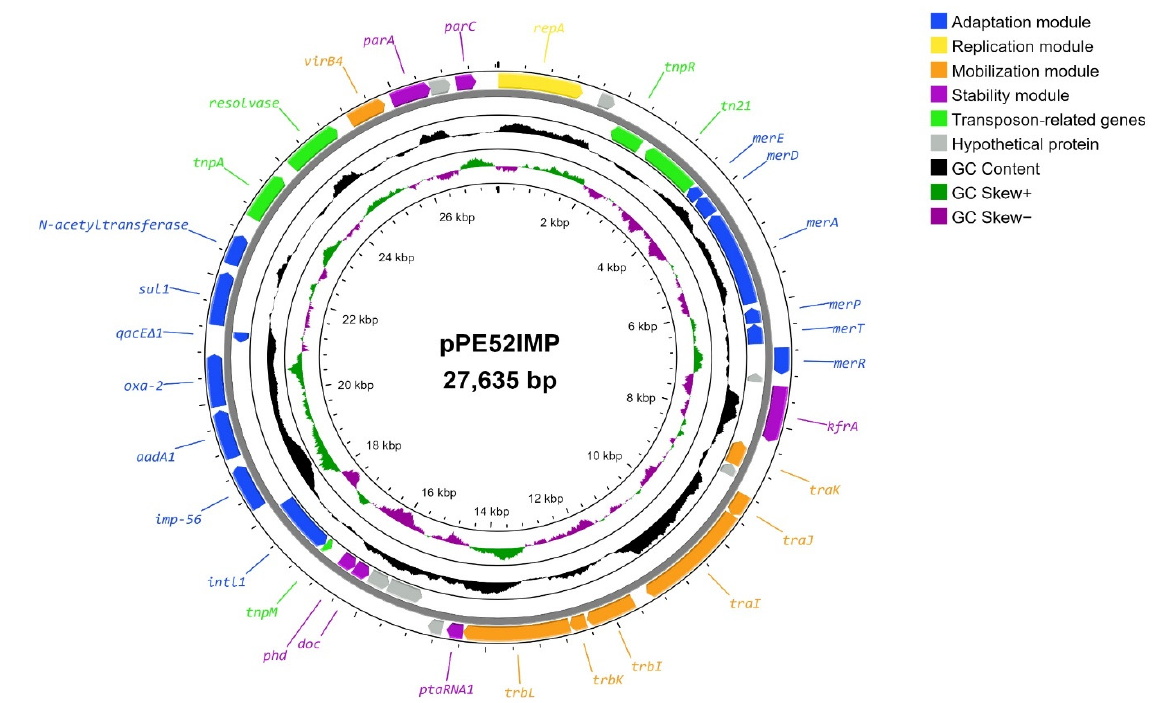
Figure 1. Structure of the pPE52IMP plasmid of P. aeruginosa strain PE52. Plasmid modules are represented with different colors. Blue: adaptation; yellow: replication; orange: mobilization; purple: stability; green: transposons; gray: hypothetical proteins. GC content, GC skew+ and GC skew– are represented in colors black, purple and green, respectively on the inner map.